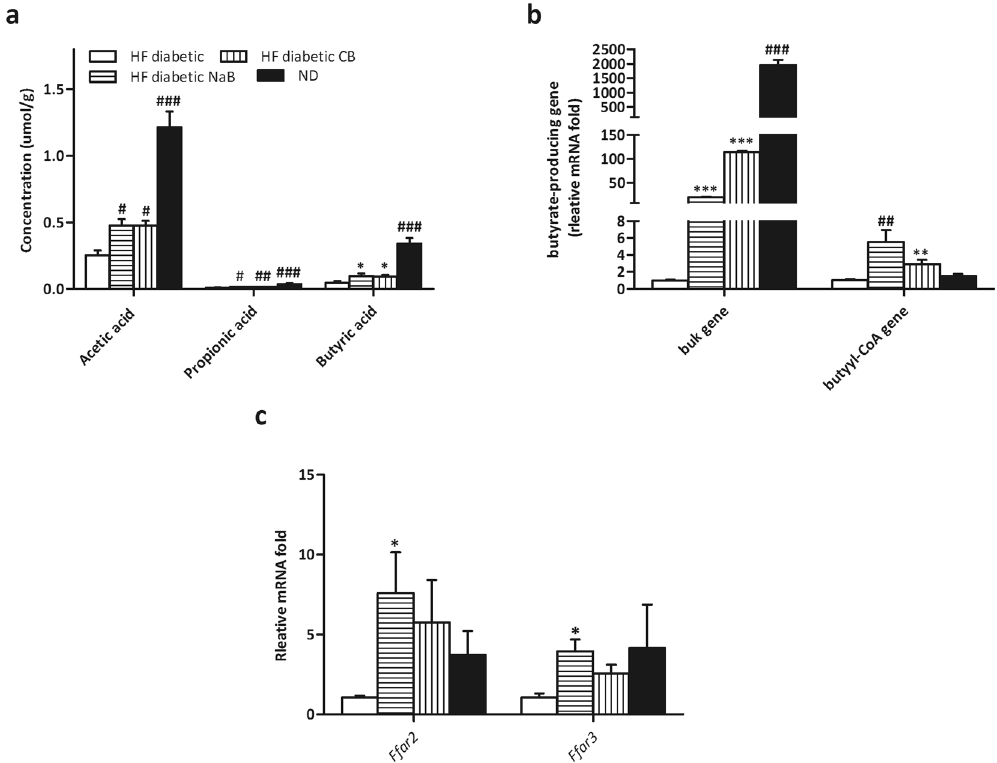
Figure 7. CB0313.1 upregulates butyrate production by buk and butyryl - CoA genes accompanied by an increase in the SCFA receptor in HF diabetic mice. ( a ) SCFA concentration in feces measured by GC-MS. Total DNA was extracted from feces and real-time PCR was performed. ( b ) Predominant butyrate producing genes: abundance of butyrate kinase ( buk ) and butyryl-CoA DNA in feces. ( c ) Relative mRNA expression of SCFA receptors ( Ffar2 , Ffar3 ) in colon. Data are mean ± SEM (n = 3–12 mice per group). #, ##, ### p < 0.05, p < 0.01, p < 0.001 vs HF diabetic control by one-way ANOVA followed by the indicated post hoc test. * , ** , *** p < 0.05, p < 0.01, p < 0.001 vs HF diabetic control by t -test. HF diabetic: high fat diet and streptozotocin, HF diabetic CB: high fat diet and streptozotocin plus CB0313.1, HF diabetic NaB: high fat diet and streptozotocin plus NaB, ND: Normal